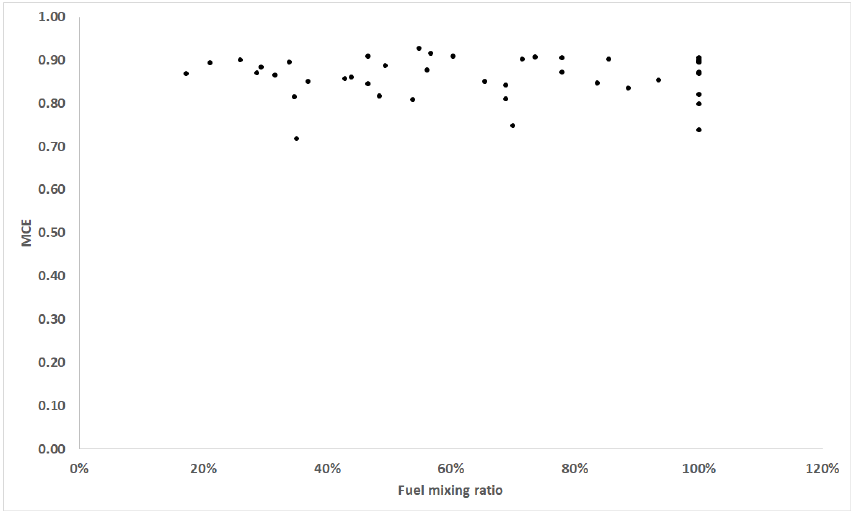
Figure 6. MCE at different fuel mixing